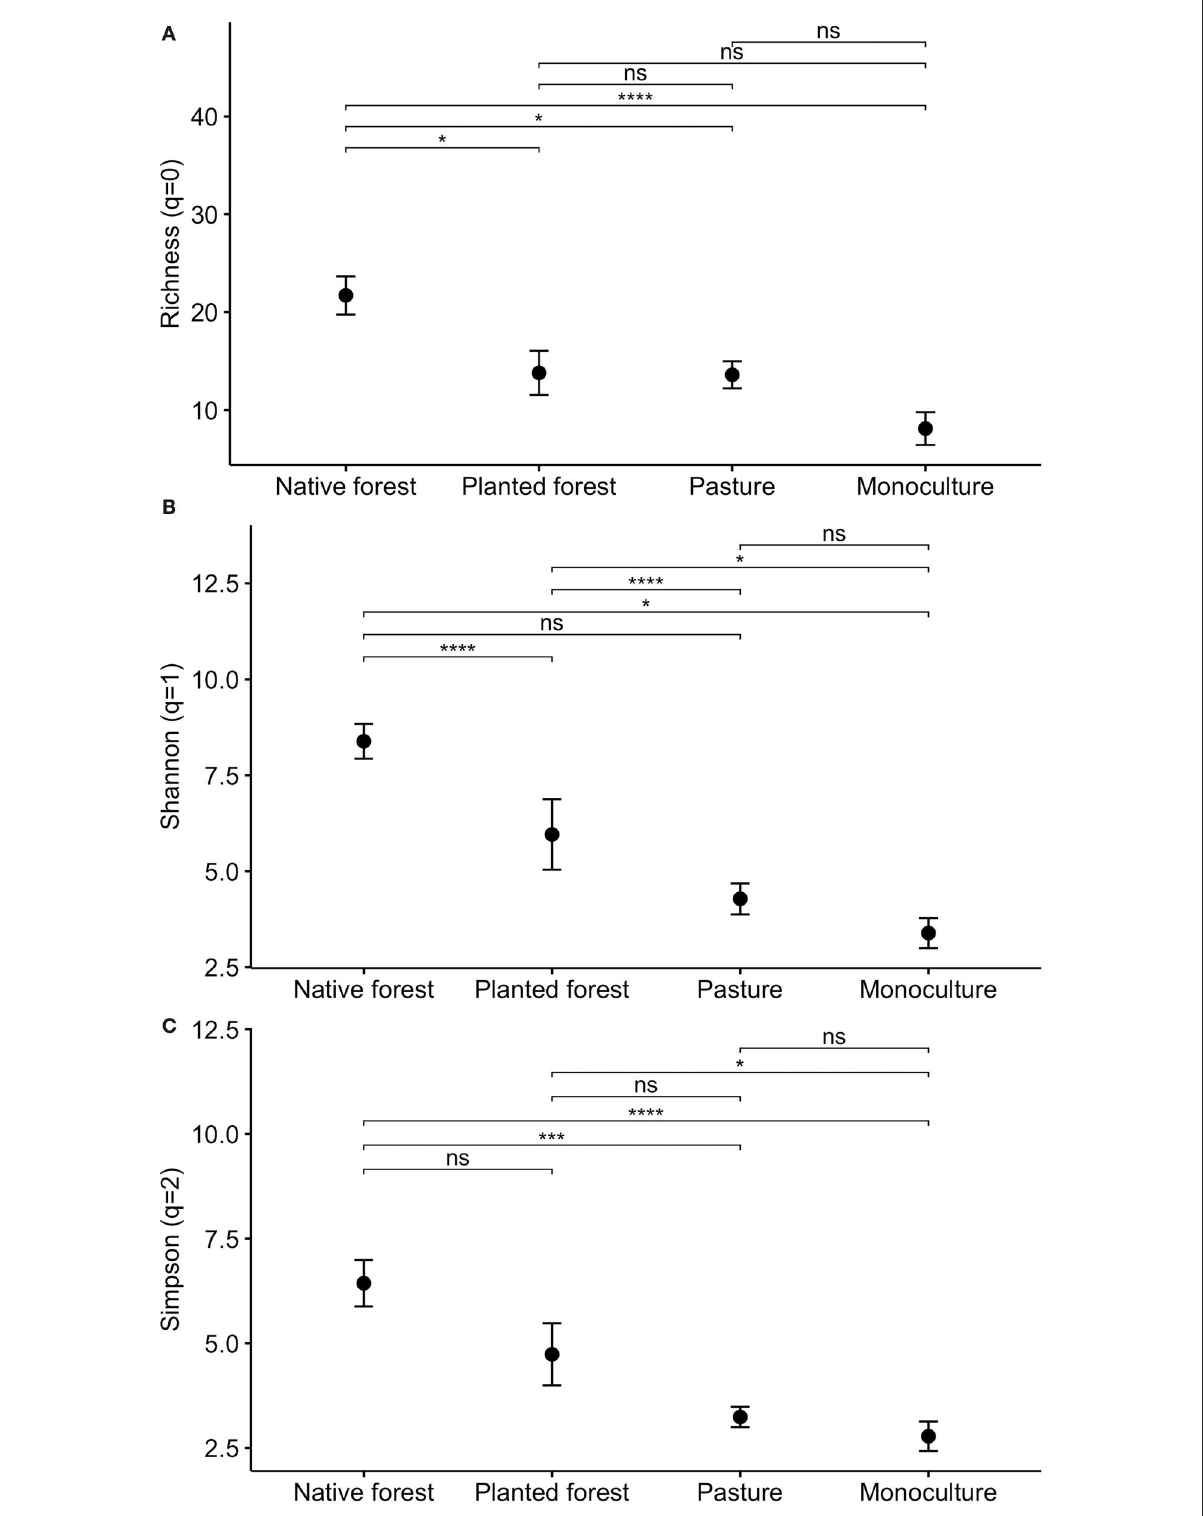
FIGURE3 Average of Hill numbers: richness (A) , Shannon (B) , and Simpson (C) of soil macroinvertebrates at genus level across the land use categories. The length of the error bars is a 95% confidence interval for the mean. Asterisks illustrate the power of the levels of significance of the statistical tests: * p ≤ 0.05; ** p ≤ 0.01; *** p ≤ 0.001; **** p ≤ 0.0001 and ns represents p >